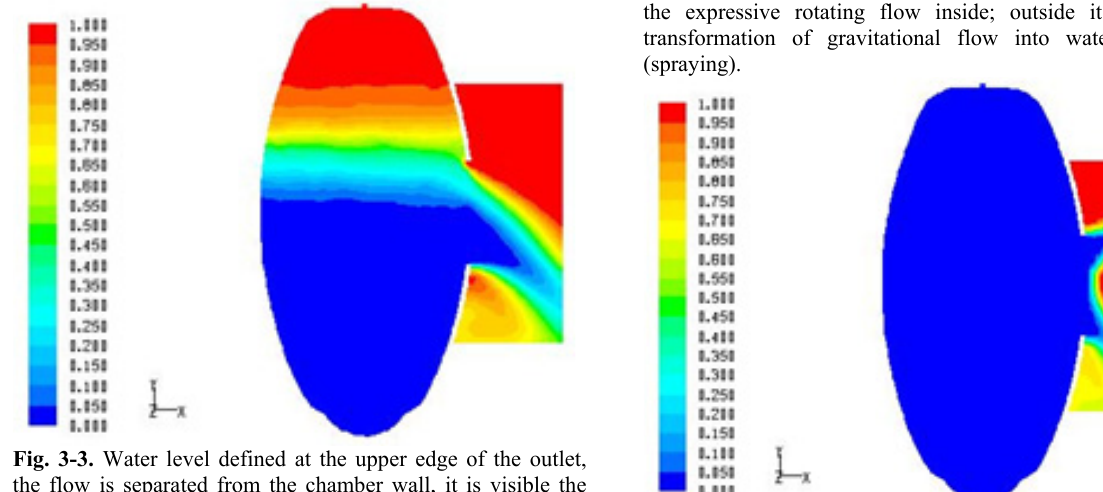
Fig. 3-2. Water level is defined just on the outlet axis, situation is similar, and the outflow is more intensive. The level (theoretically horizontal) is inclined to the outlet.